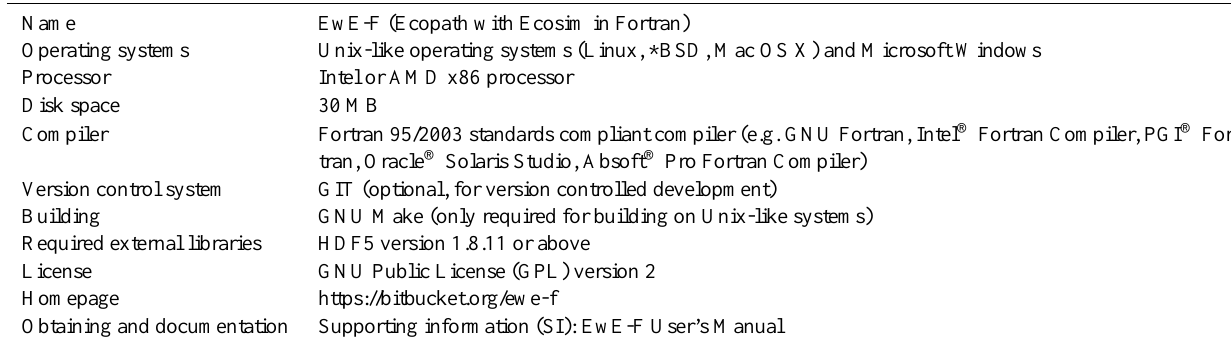
Table 1. General system and software related requirements of EwE-F